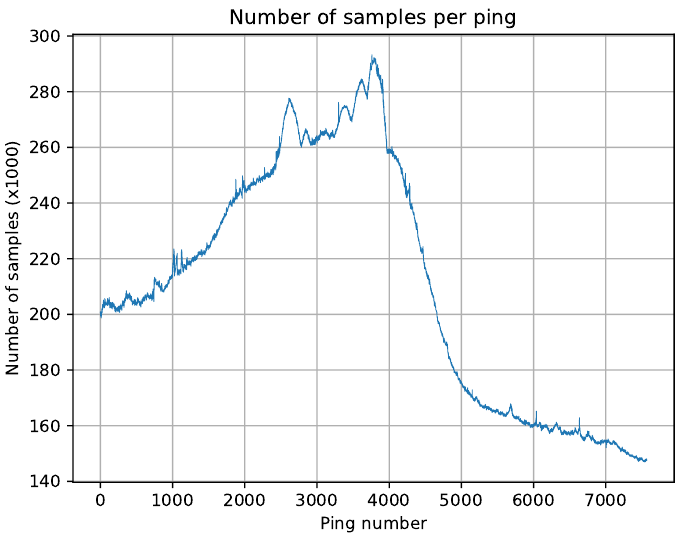
Figure 3. Number of samples per ping in a test file from a Kongsberg EM2040 echosounder.